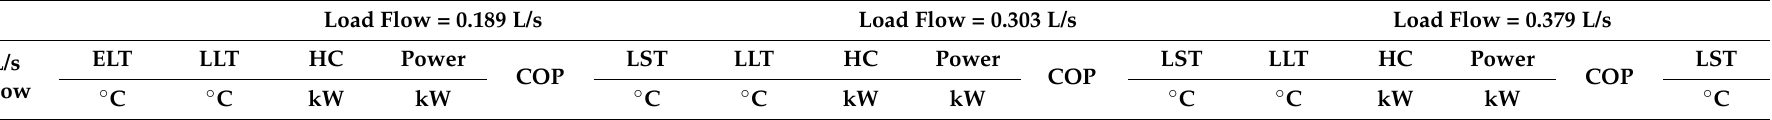
Table A1. Water-to-water heat pump catalogue